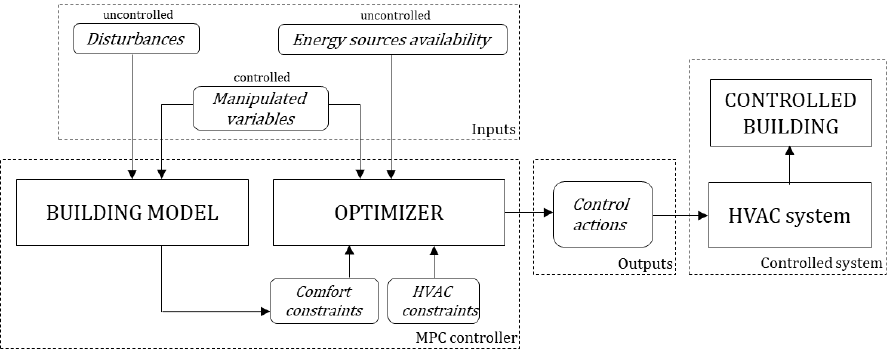
Figure 2. Scheme of the proposed MPC for exploiting MESs in buildings.